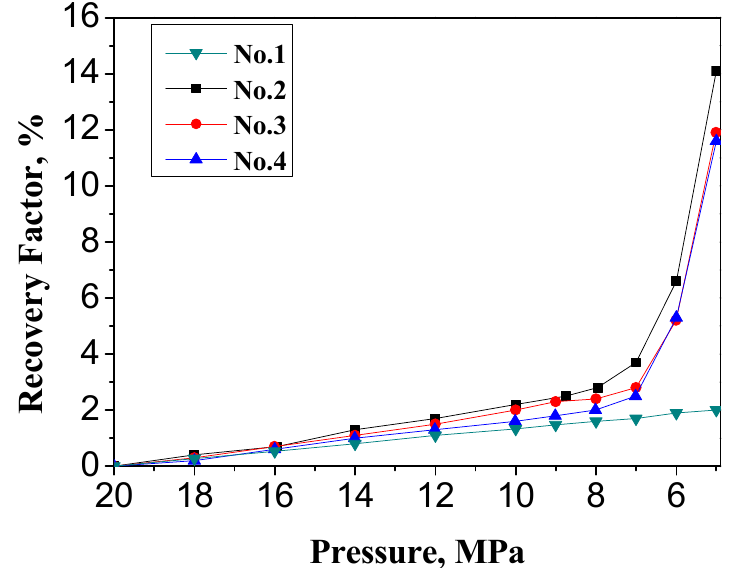
Figure 8. Recovery factor of live and dead oil depletion.